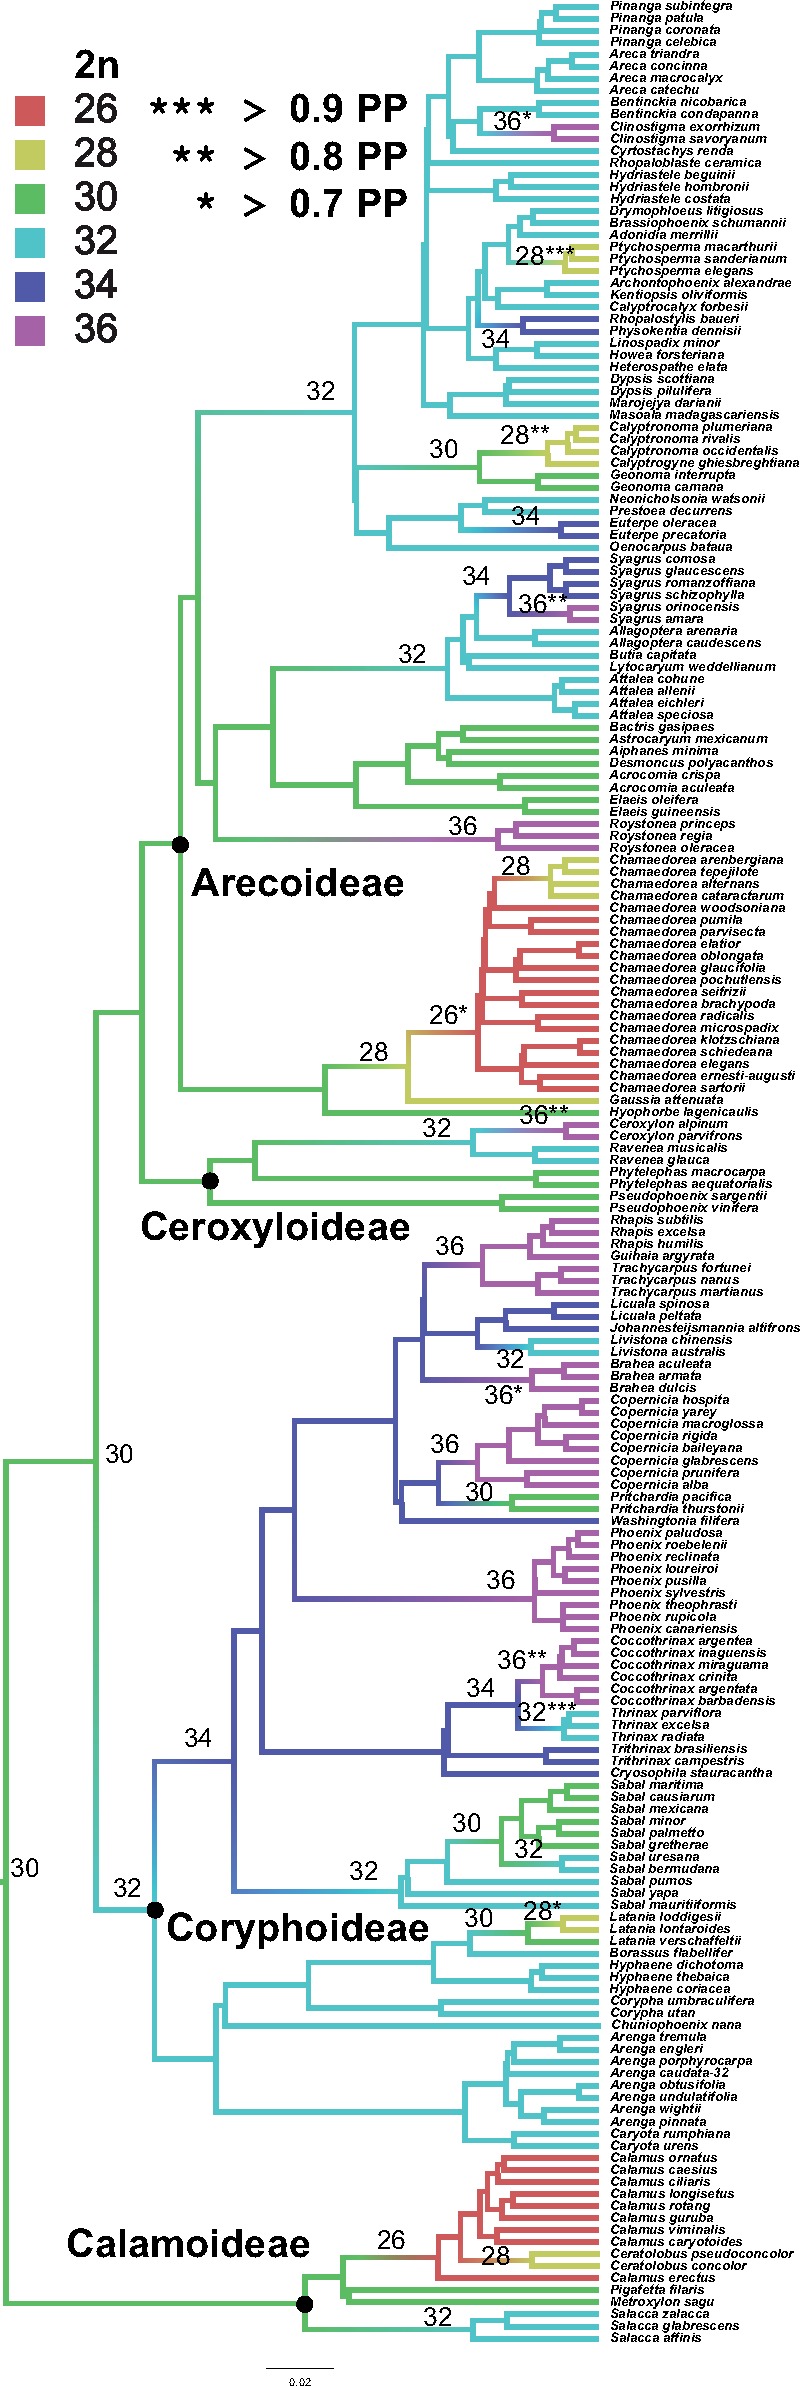
—Maximum-likelihood estimate of ancestral state reconstruction of chromosome number based on a model of linear rate dependency in ChromEvol (i.e., chromosome number changes depend on the current chromosome number), allowing both ascending and descending dysploid changes (i + 1, i − 1) and WGD (2i). Colors correspond to 2n chromosome numbers, and numbers in brackets indicate the ML estimate of chromosome number for that node. Asterisks refer to the posterior probability for the highest-likelihood reconstruction of chromosome number. Black dots correspond to four of the five palms subfamilies sampled.